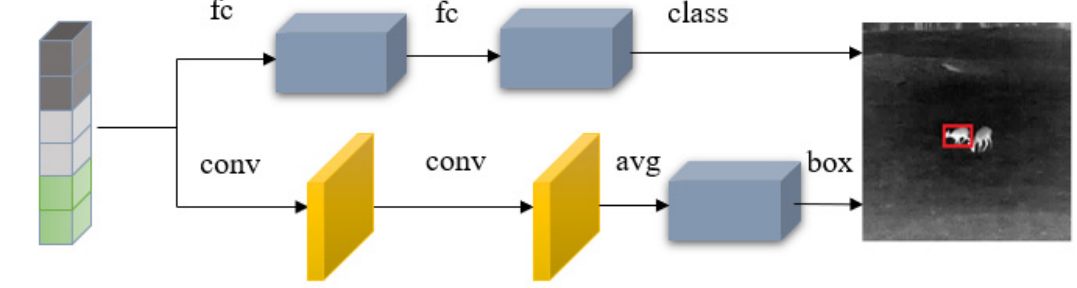
convolutional Figure 7. The focus self-attention in the window level. fc is the fully connected layer. conv is the convolutional layer.